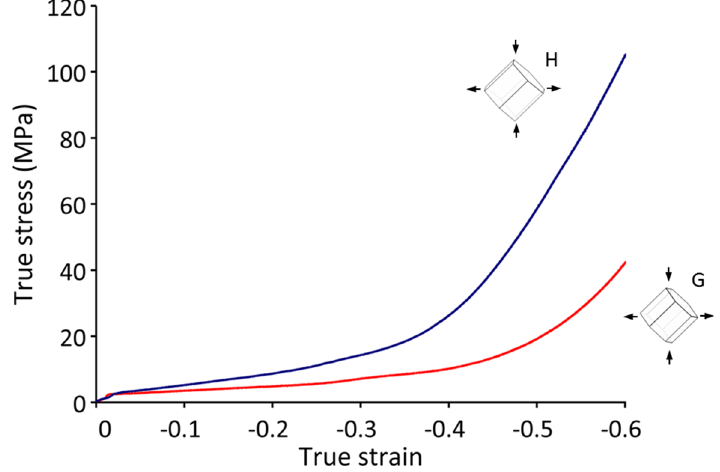
Figure 18. Flow curves of pure Mg single crystals of orientations G and H (45 ◦ between CD and the c -axis) deformed by PSC at ambient temperature and a constant strain rate of 10 − 3 s − 1 . Oil was used for